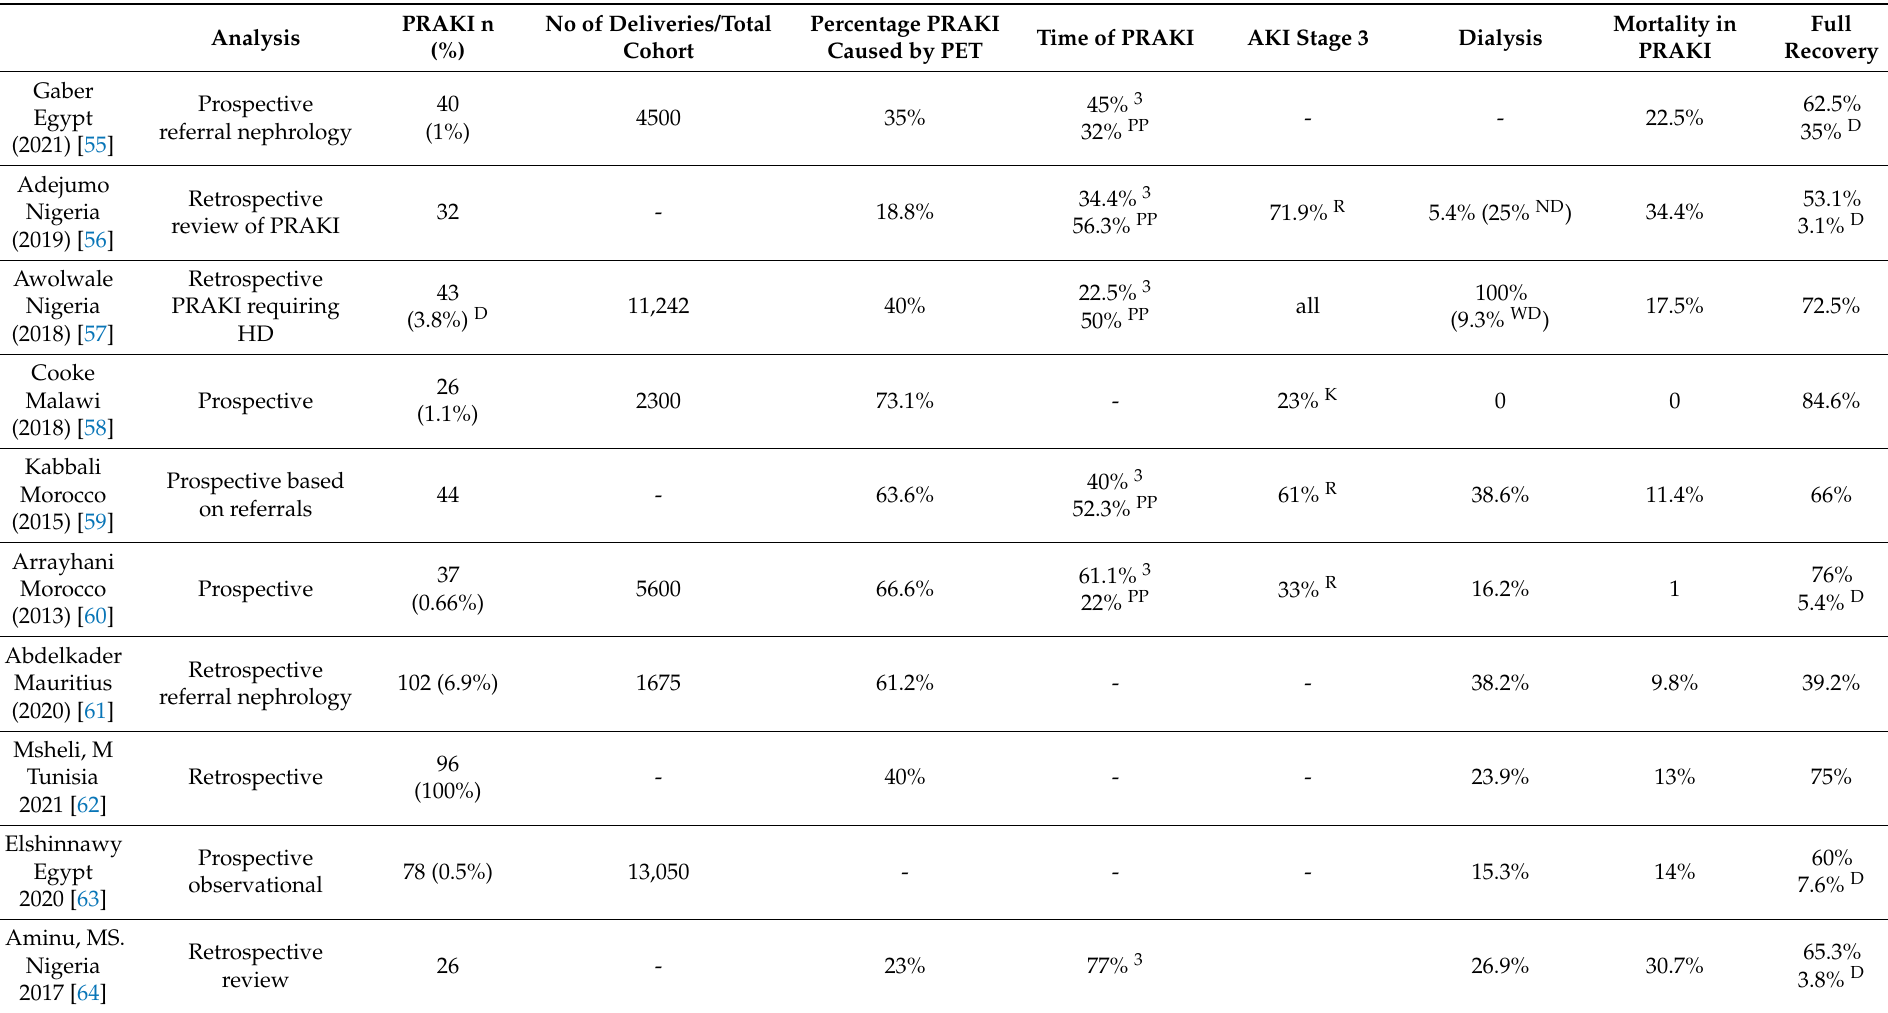
Table 1. Studies related to PRAKI in Obstetric cohorts or referral to